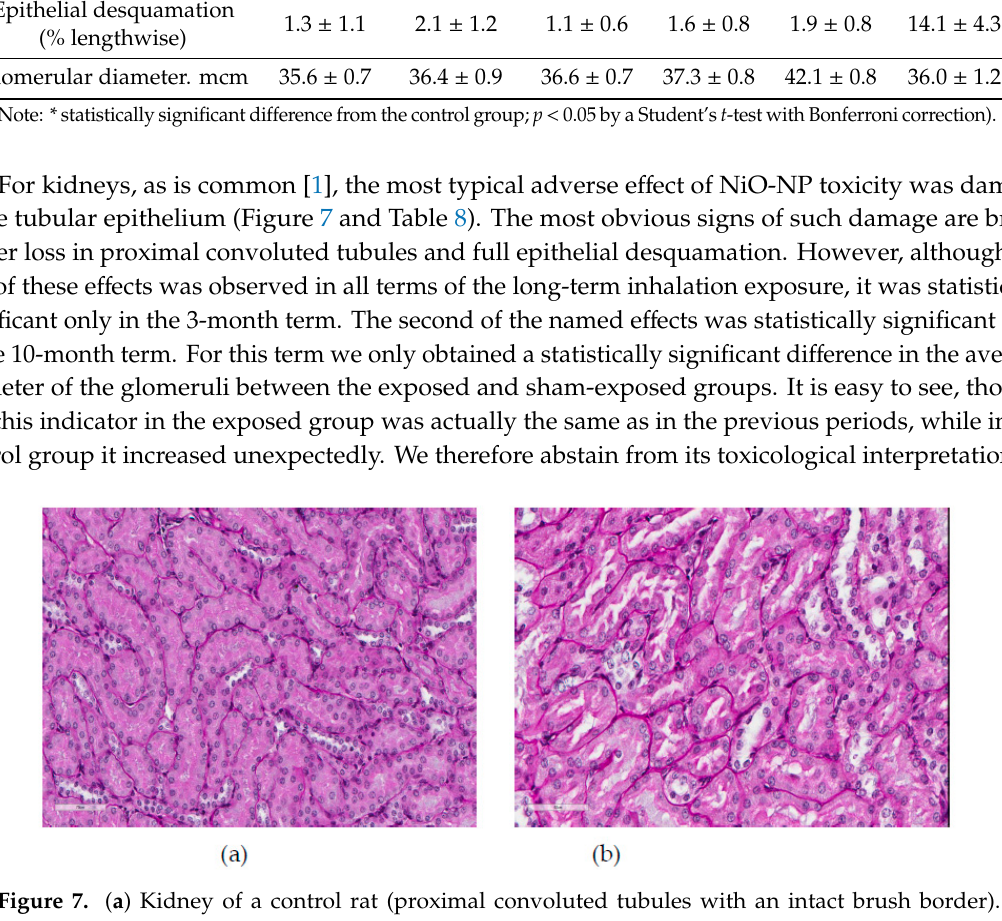
Table 9. Some cytological characteristics of different organ imprints in rats sacrificed on the next day after the last 4 h inhalation exposure to NiO-NPs at a 0.23 ± 0.01 mg/m 3 concentration; percentage of total cell count ( x ± s.e. ).